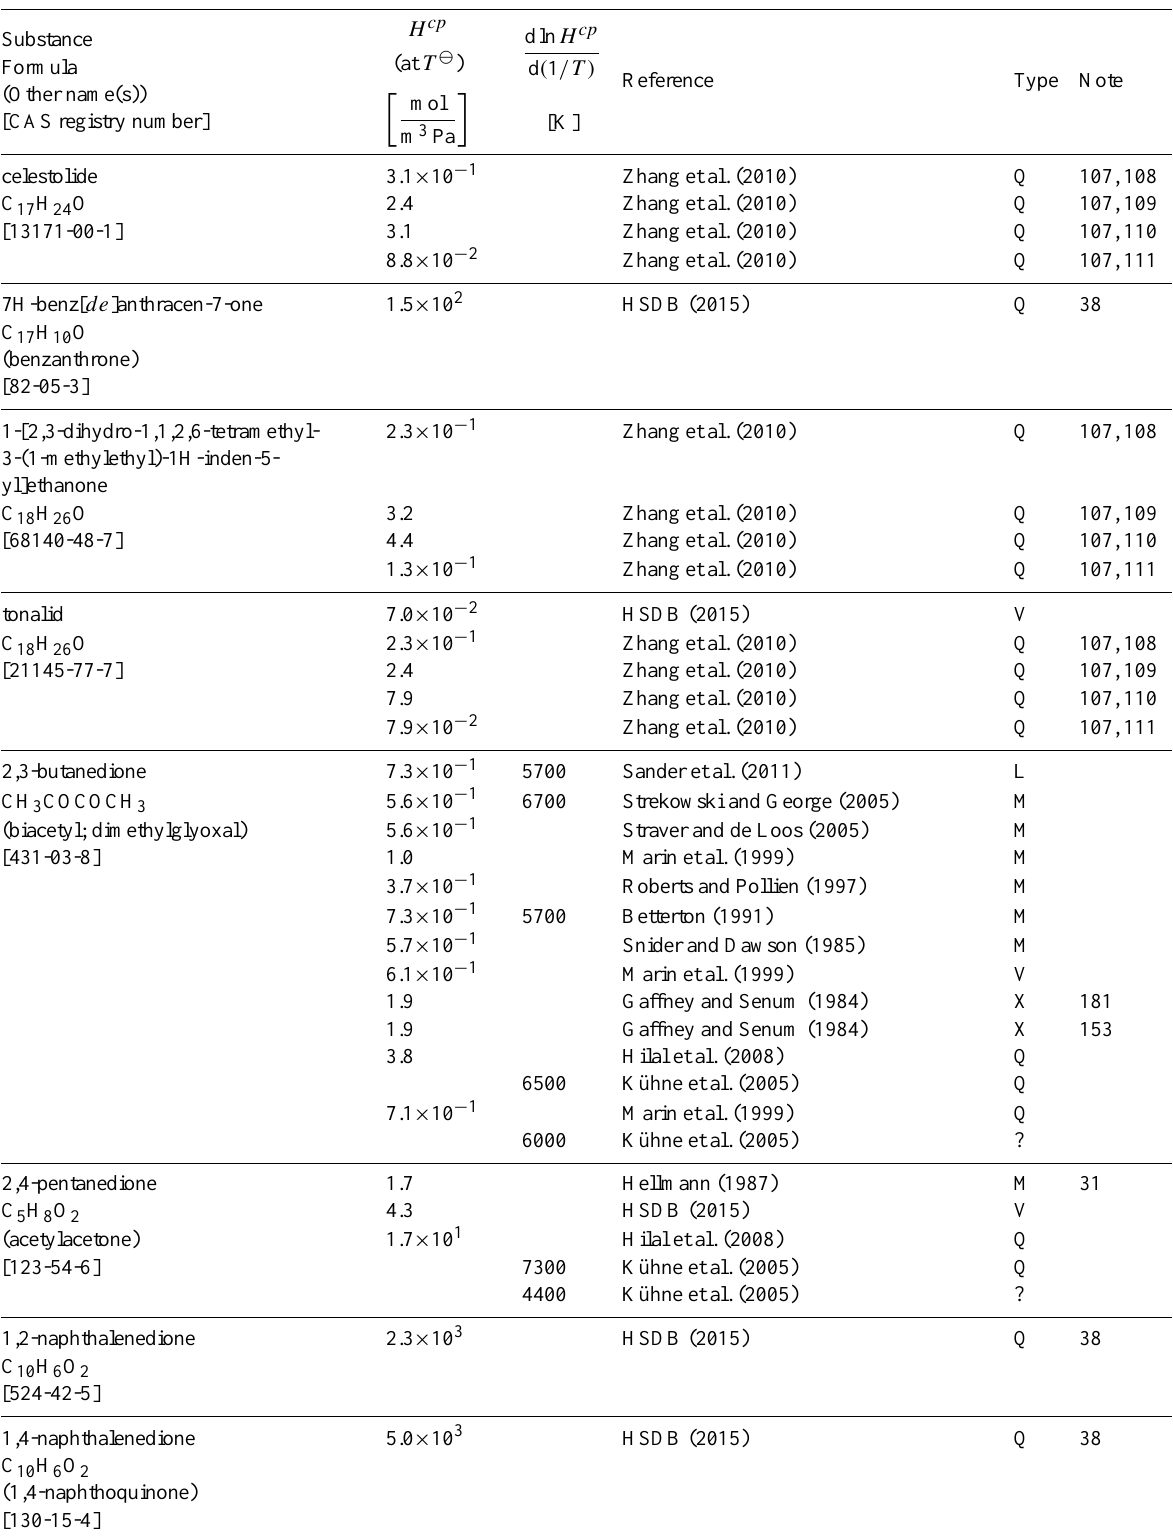
Table 6: Henry’s law constants for water as solvent